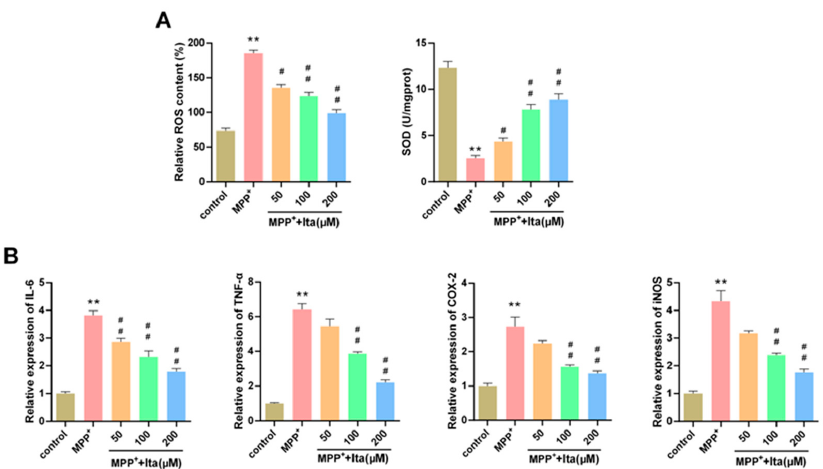
Figure 7. Itaconate attenuated oxidative stress and inflammatory response in MPP + revulsive PD cell model. ( A ) ROS and SOD level in MPP + revulsive PD cell model. The image acquisition param- eters: image resolution ( − 4908 × 3264), objective (10×), and exposure settings (DAPI: 5 ms; TH: 200 ms). ( B ) IL-6, TNF- α , COX-2, and iNOS levels in MPP + revulsive PD cell model were detected using qRT-PCR. n = 3. ** p < 0.01 vs. control group, # p < 0.05, ## p < 0.01 vs. MPP + group. Ita, Itaconate.